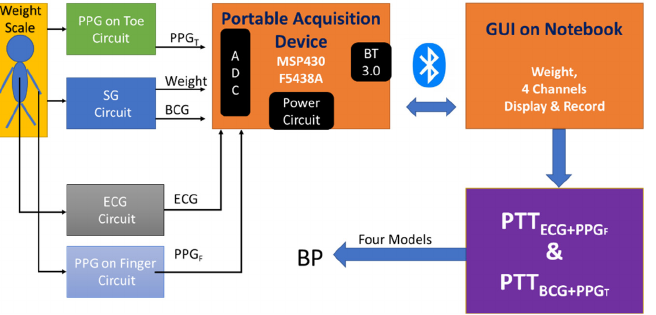
Figure 1. The structure diagram of measurement system including the sensor circuits, portable acquisition device and a graphic user interface (GUI) on the notebook. The PTTECG + PPGF and PTTBCG + PPGT are used to estimate BP with four models. PPG: point of photoplethysmogram; SG: strain gauges; ECG: electrocardiogram; BCG: ballistocardiogram; PTT: pulse transit time; BP: blood pressure.